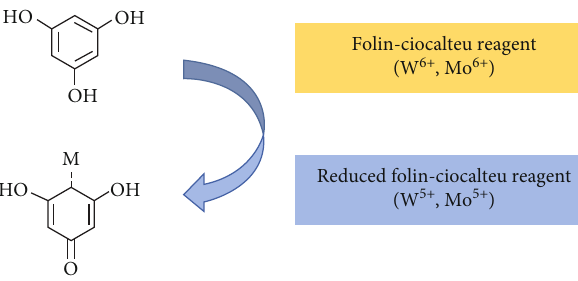
Figure 1: Chemical representation, color change, in the F-C reaction (W, tungsten; Mo, molybdenum reacting with polyphenol groups in an oxidation-reduction reaction)